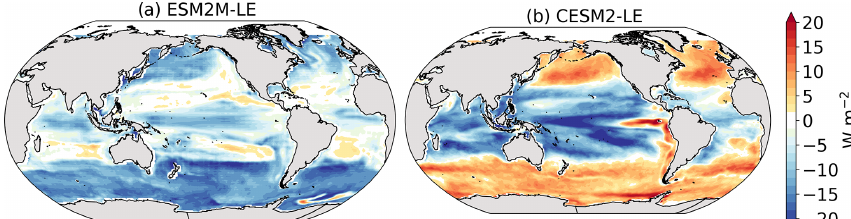
Figure B8. Surface photosynthesis available radiation anomaly (Wm − 2 ) during MHW–NPPX events relative to the seasonal cycle in ESM2M-LE (a) and in CESM2-LE (b)